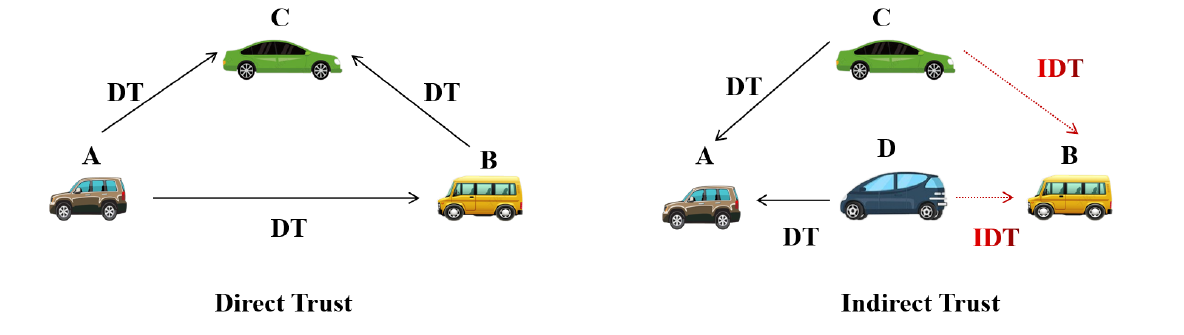
Figure 5. Classification of